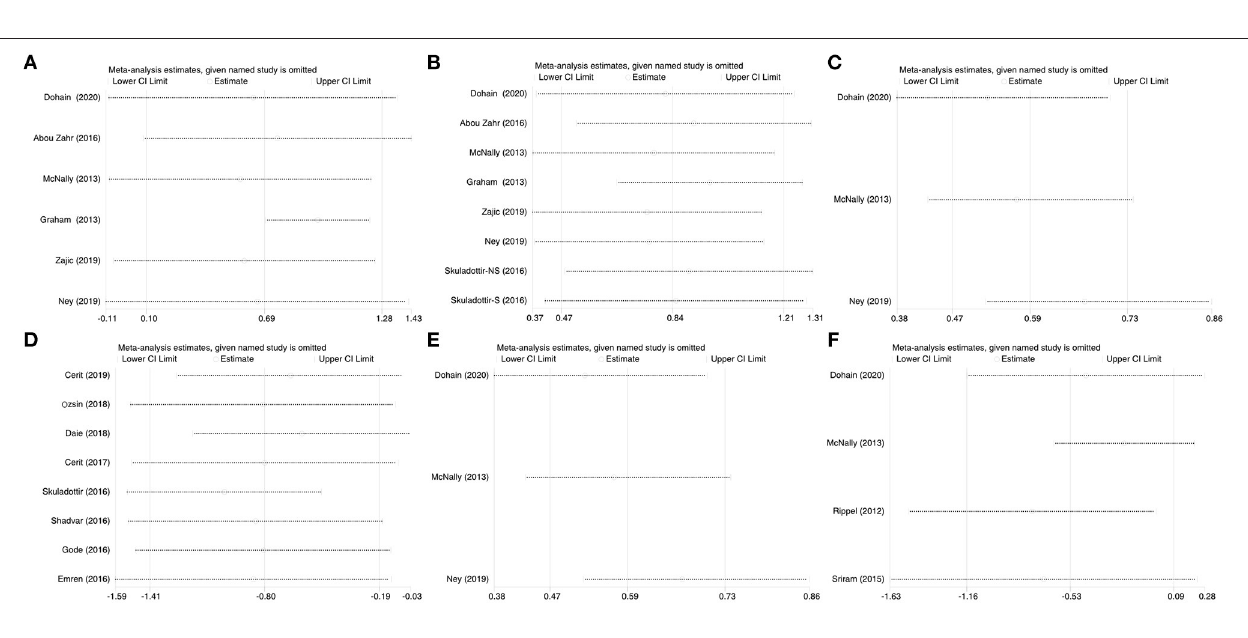
FIGURE 8 | Sensitivity analysis of the individual trials on the results. (A) For the VitD level preoperative and immediate post cardiac surgery; (B) For the VitD level preoperative and 24-h post cardiac surgery; (C) For the RRs of VitD deficiency rate of pre- and 24-h post-cardiac surgery; (D) For the relationship between VitD level and severe events; (E) For the relationship between VitD level and maximum VIS; (F) For the relationship between VitD level and ICU stay duration.